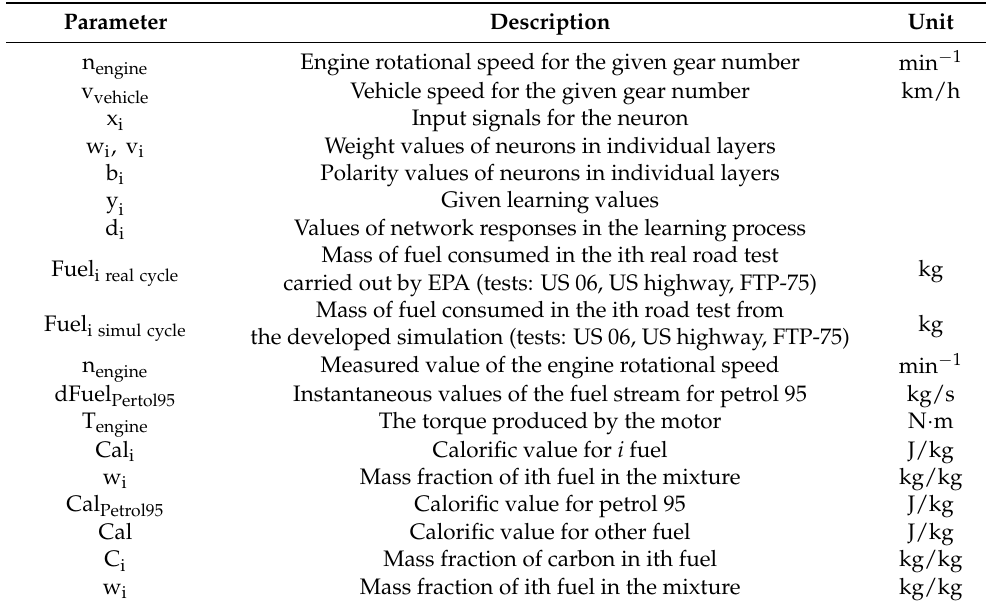
Table 1. Abbreviations, symbols and units used in the paper.